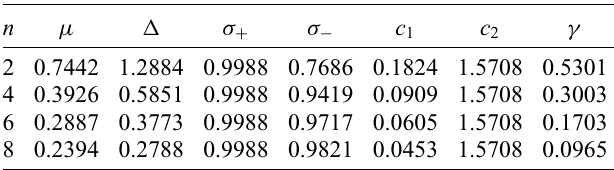
TABLE III. The system-dependent parameters for different numbers of system qubits n .